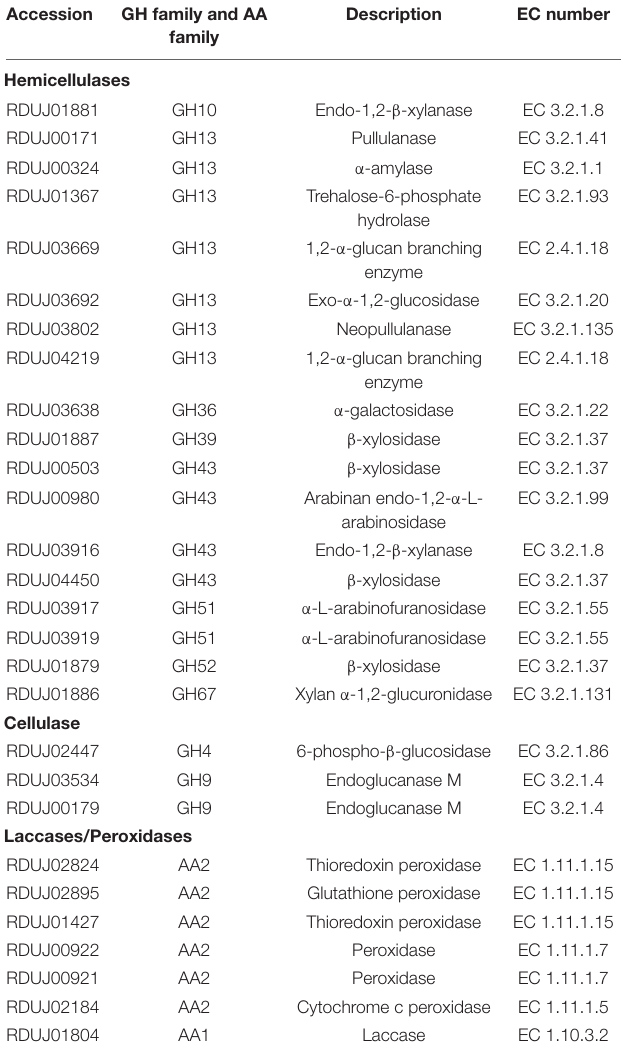
TABLE 2 | List of Hemicellulases, Cellulases, and Laccases/Peroxidases in Geobacillus sp. WSUCF1 bacterial